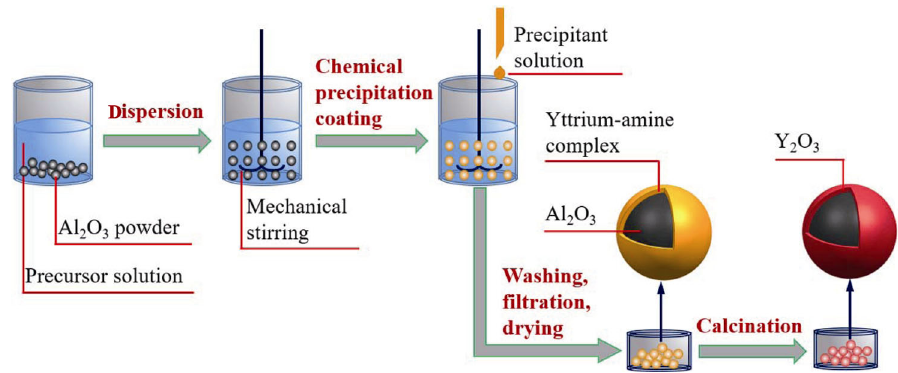
Fig. 1 Schematic illustration of the chemical precipitation coating